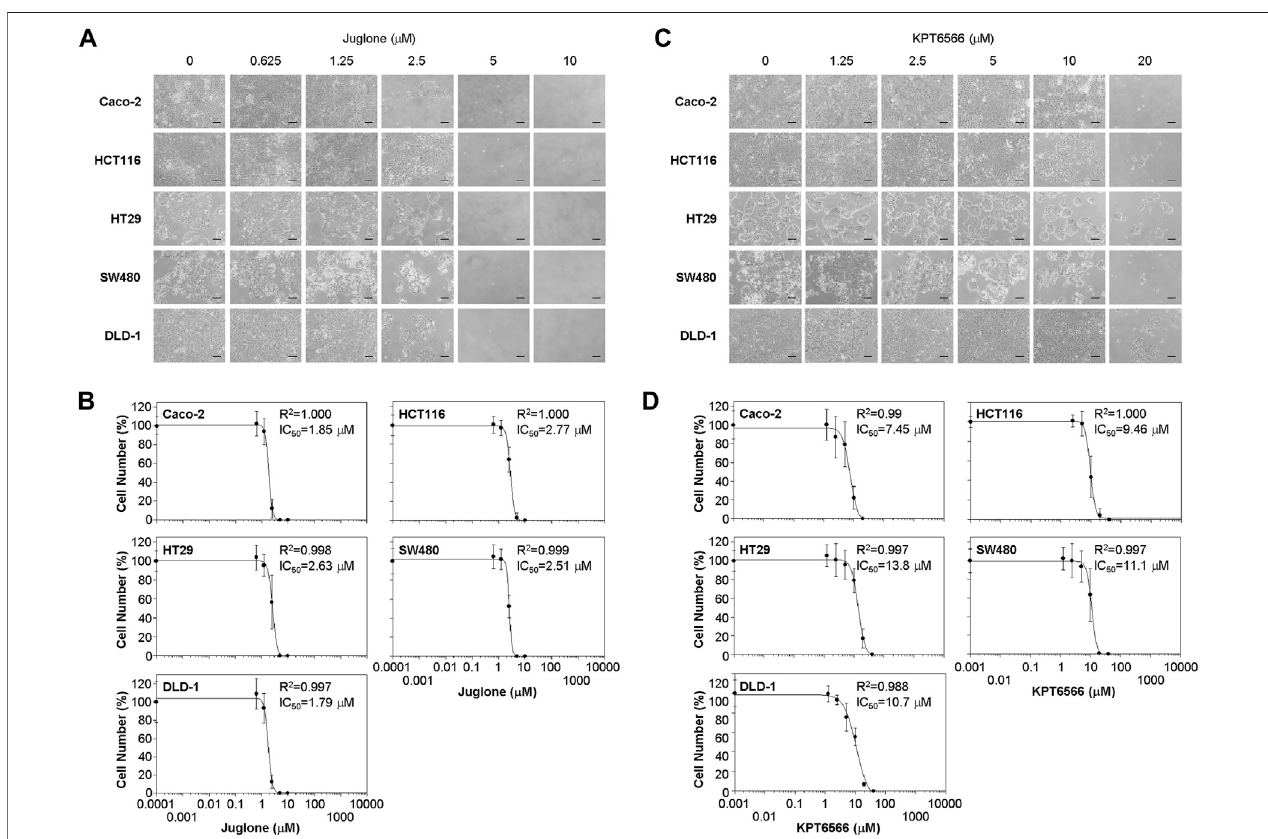
FIGURE 2 | Suppression of colorectal cancer cell proliferation by Juglone and KPT6566. (A) Morphology of fi ve colorectal cancer cell lines exposed to Juglone. Caco-2, HCT116, HT29, SW480, and DLD-1 cells (1 × 10 4 ) were cultured with various amounts of Juglone. Phase-contrast micrographs show the growth of individual colorectal cancer cells 6 days after Juglone treatment. Individual colorectal cancer cells were monitored under an inverted phase-contrast microscope (IX71; Olympus). Scale bars, 100 μ m. Three independent experiments were performed, all of which gave similar results. (B) Inhibition of colorectal cancer cell proliferation by Juglone. Caco-2, HCT116, HT29, SW480, and DLD-1 colorectal cancer cells were treated with the indicated concentrations of Juglone, and the number of cells was counted using a hemocytometer. Inhibition of cell growth is presented as a percentage relative to untreated control (DMSO) cells at a given concentration of Juglone. Dataareexpressedasthemean±S.D.offourindependentexperiments.Asigmoidaldose-responsecurveprovidedbySoftMaxProsoftwarewasusedtocalculatethe IC 50 valueforJuglone.Threeindependentexperimentswereperformed,allofwhichgavesimilarresults. (C) EffectofKPT6566oncolorectalcancercellgrowth.Caco-2, HCT116, HT29, SW480, and DLD-1 cells (1 × 10 4 ) were incubated with different doses of KPT6566 and monitored for 6 days under an inverted phase-contrast microscope(IX71;Olympus).Scalebars,100 μ m.Threeindependentexperimentswereperformed,allofwhichgavesimilarresults. (D) Inhibitionofcolorectalcancercell proliferation by KPT6566. Caco-2, HCT116, HT29, SW480, and DLD-1 colorectal cancer cells were treated with the indicated concentrations of KPT6566, and the number of cells was counted using a hemocytometer. Inhibition of cell growth is presented as a percentage relative to untreated control (DMSO) cells at a given concentration of KPT6566. Data are expressed as the mean ± S.D. of four independently performed experiments. A sigmoidal dose-response curve provided by SoftMax Pro software was used to calculate the IC 50 value for KPT6566. Three independent experiments were performed, all of which gave similar results.